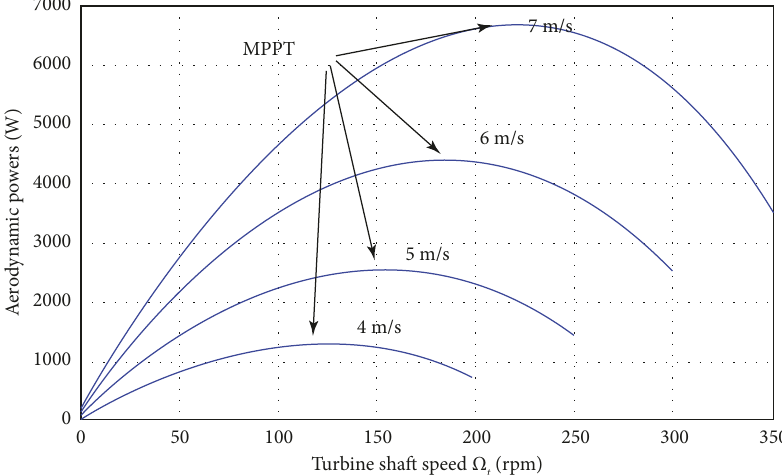
Figure 2: Maximum power efficiency of the wind turbine.